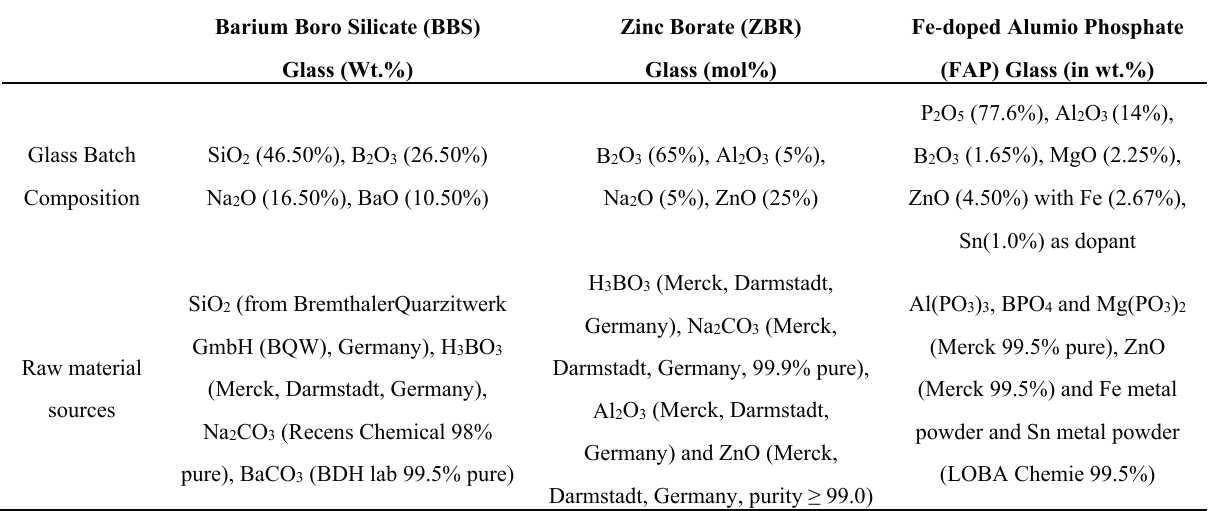
Table 1. Batch composition and raw material used for BBS, ZBR and FAP